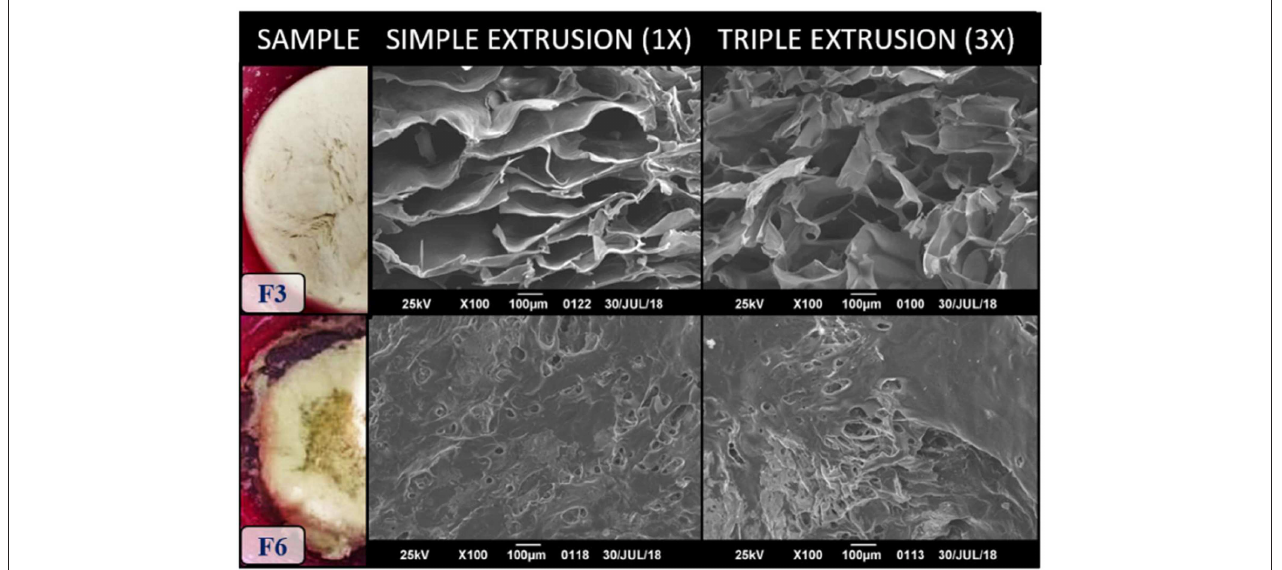
FIGURE 6 | Scanning electron micrographies comparison of the bioinks after simple (1X) and triple (3X) extrusion. The appearance of the lyophilized samples is shown on the left side.